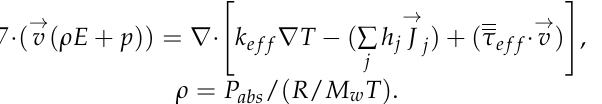
Figure 4. Distribution of wall Y+ values on the wings and fuselage surface.